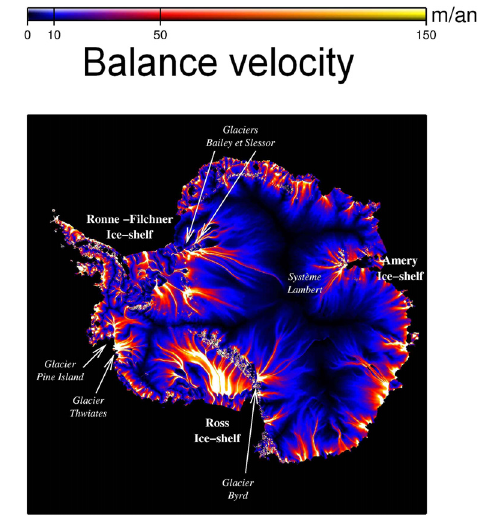
Figure 8. Map of the balance velocity expressed in m/yr from [15]. Note the presence of numerous ice streams that can be followed far away in the upslope direction. The name and location of the main outlet glaciers are